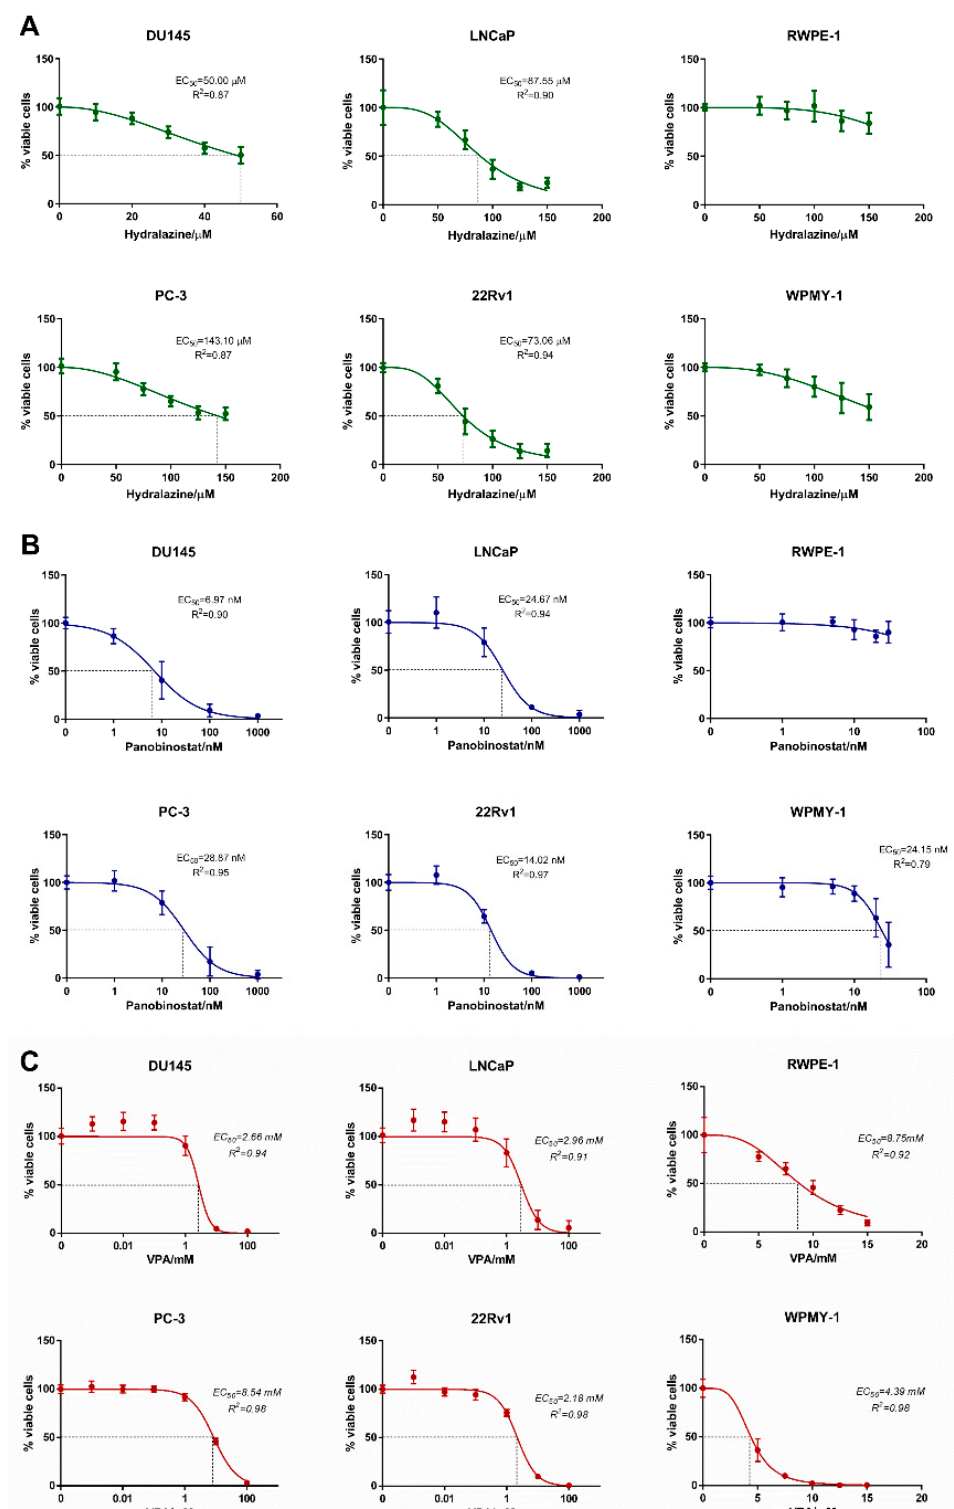
Figure 1. Dose–response curves. Cell viability measured by resazurin in DU145, PC-3, LNCaP, 22Rv1, RWPE-1 and WPMY-1 exposed to hydralazine ( A ), panobinostat ( B ) and valproic acid ( C ) at day 3. Experiments were performed in triplicates of three biological replicates ( n = 3), normalized to the respective vehicle and to day 0. EC 50 values at day 3 are indicated in each graph.